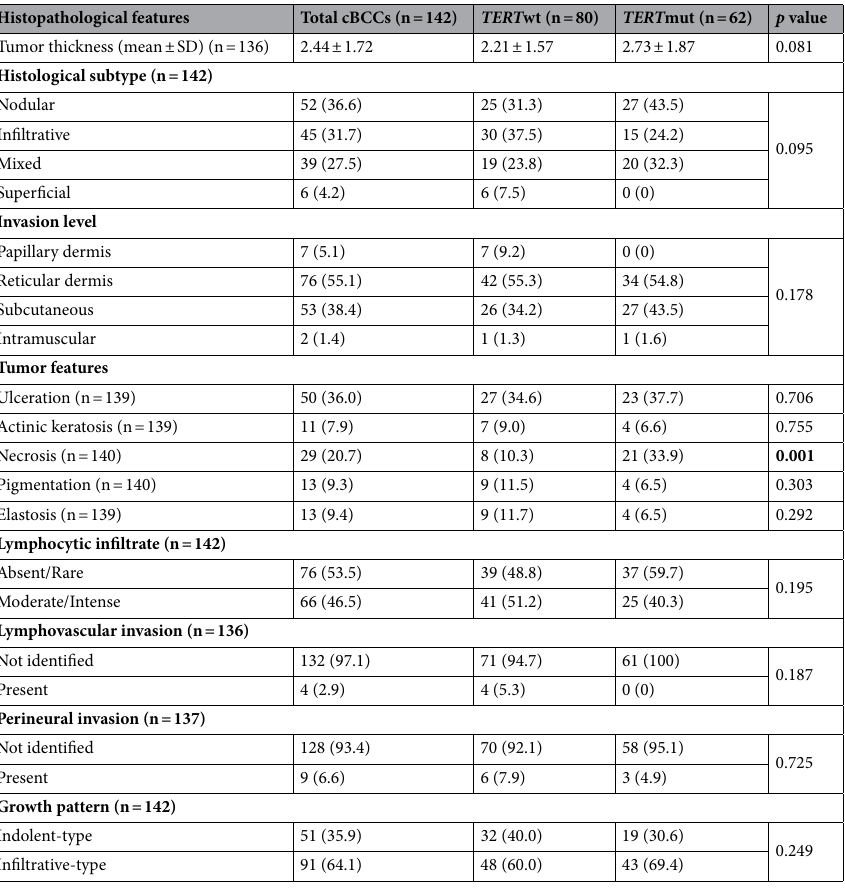
Table 4. cBCCs histopathological features and TERTp mutation status. Bold - significant difference ( p -value < 0.05).